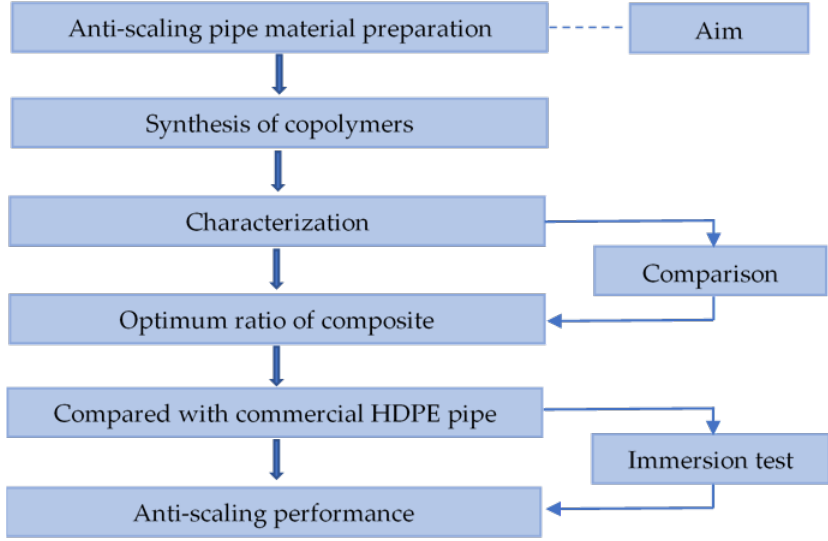
Figure 1. Experiment design for the composite preparation and characterization.